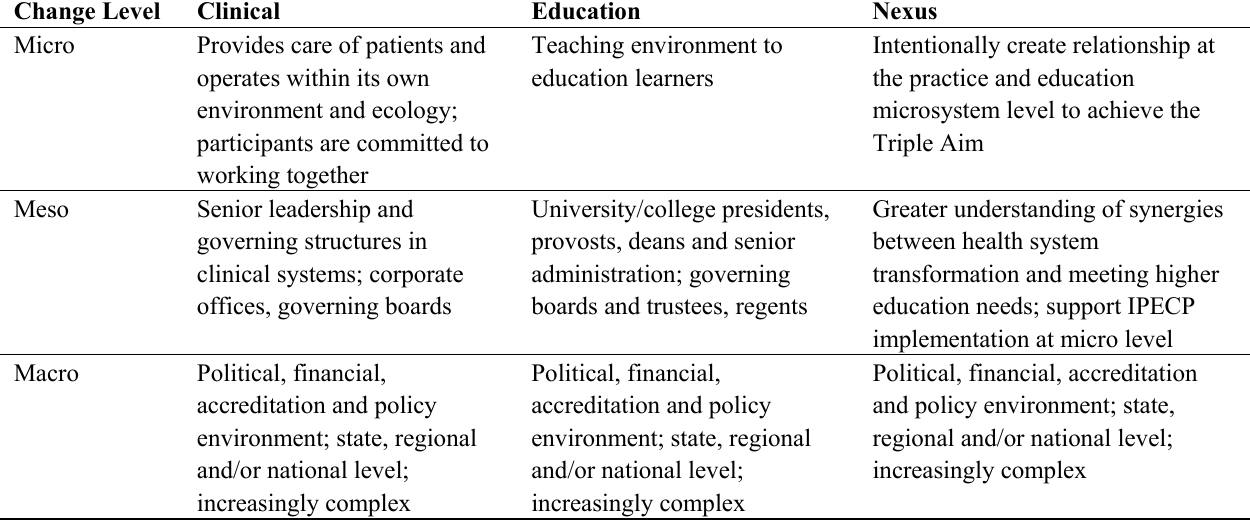
Table 1. Level of change defined by